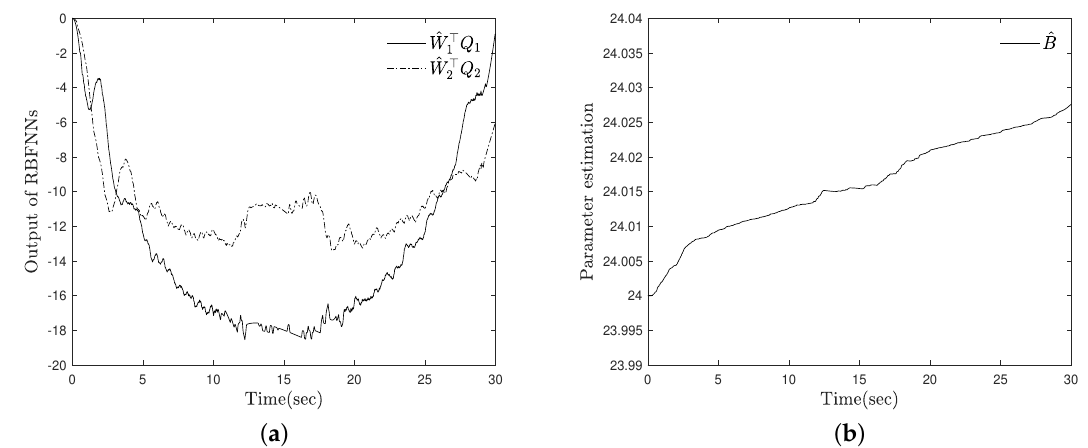
(cid:62) ˆ W (cid:62) ˆ B 1 Q 1 and 2 Q 2 ( b )